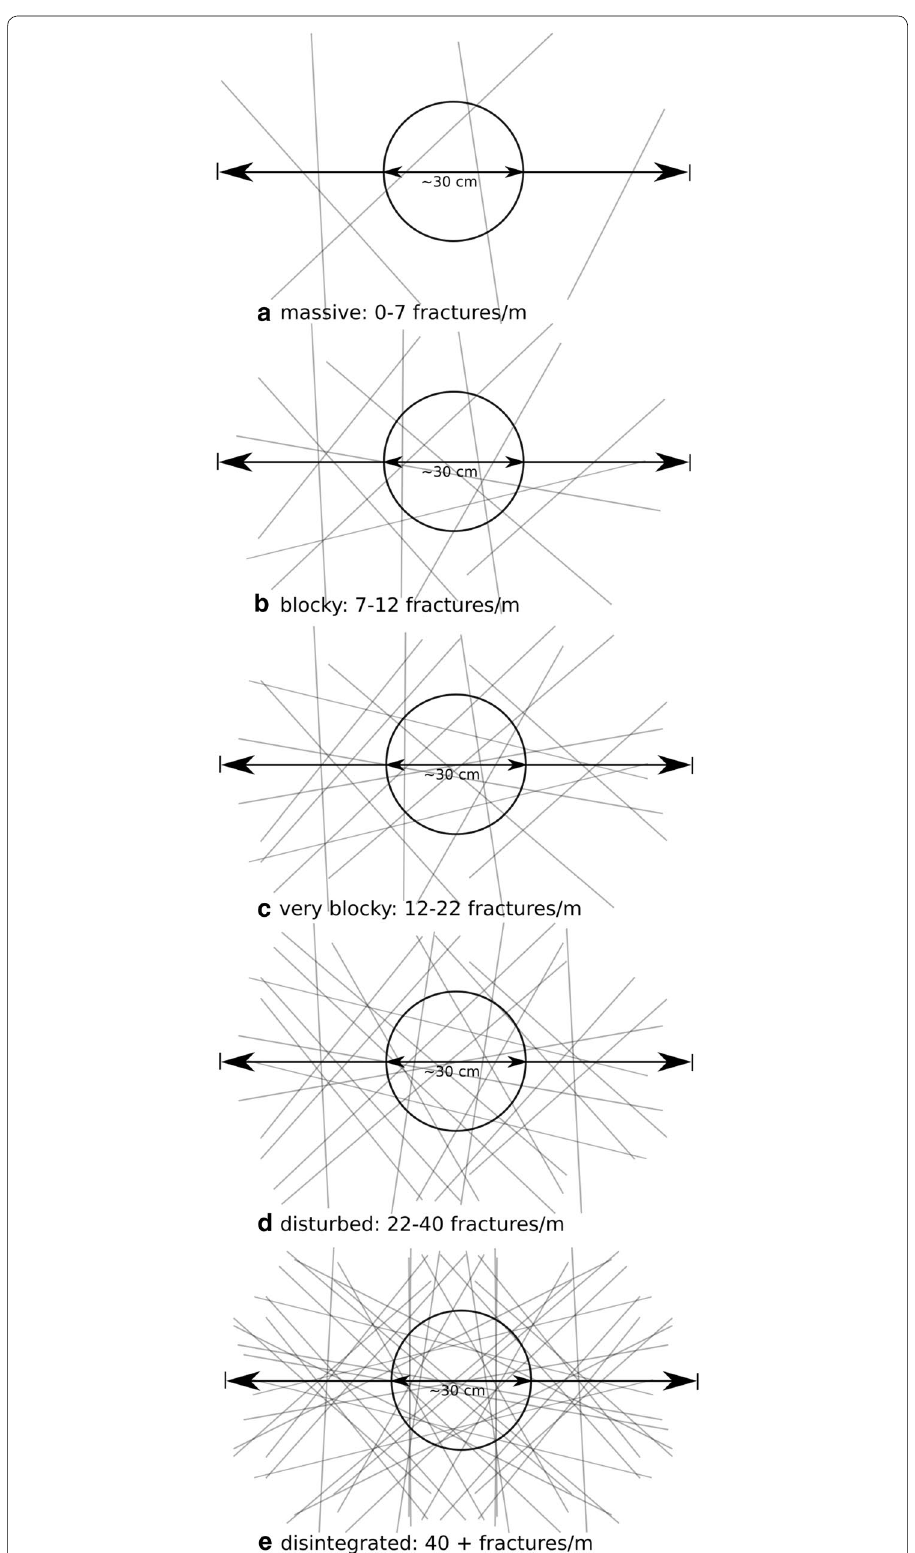
Fig. 5 Example wellbore-rock mass scale conditions for a ~ 30 cm diameter